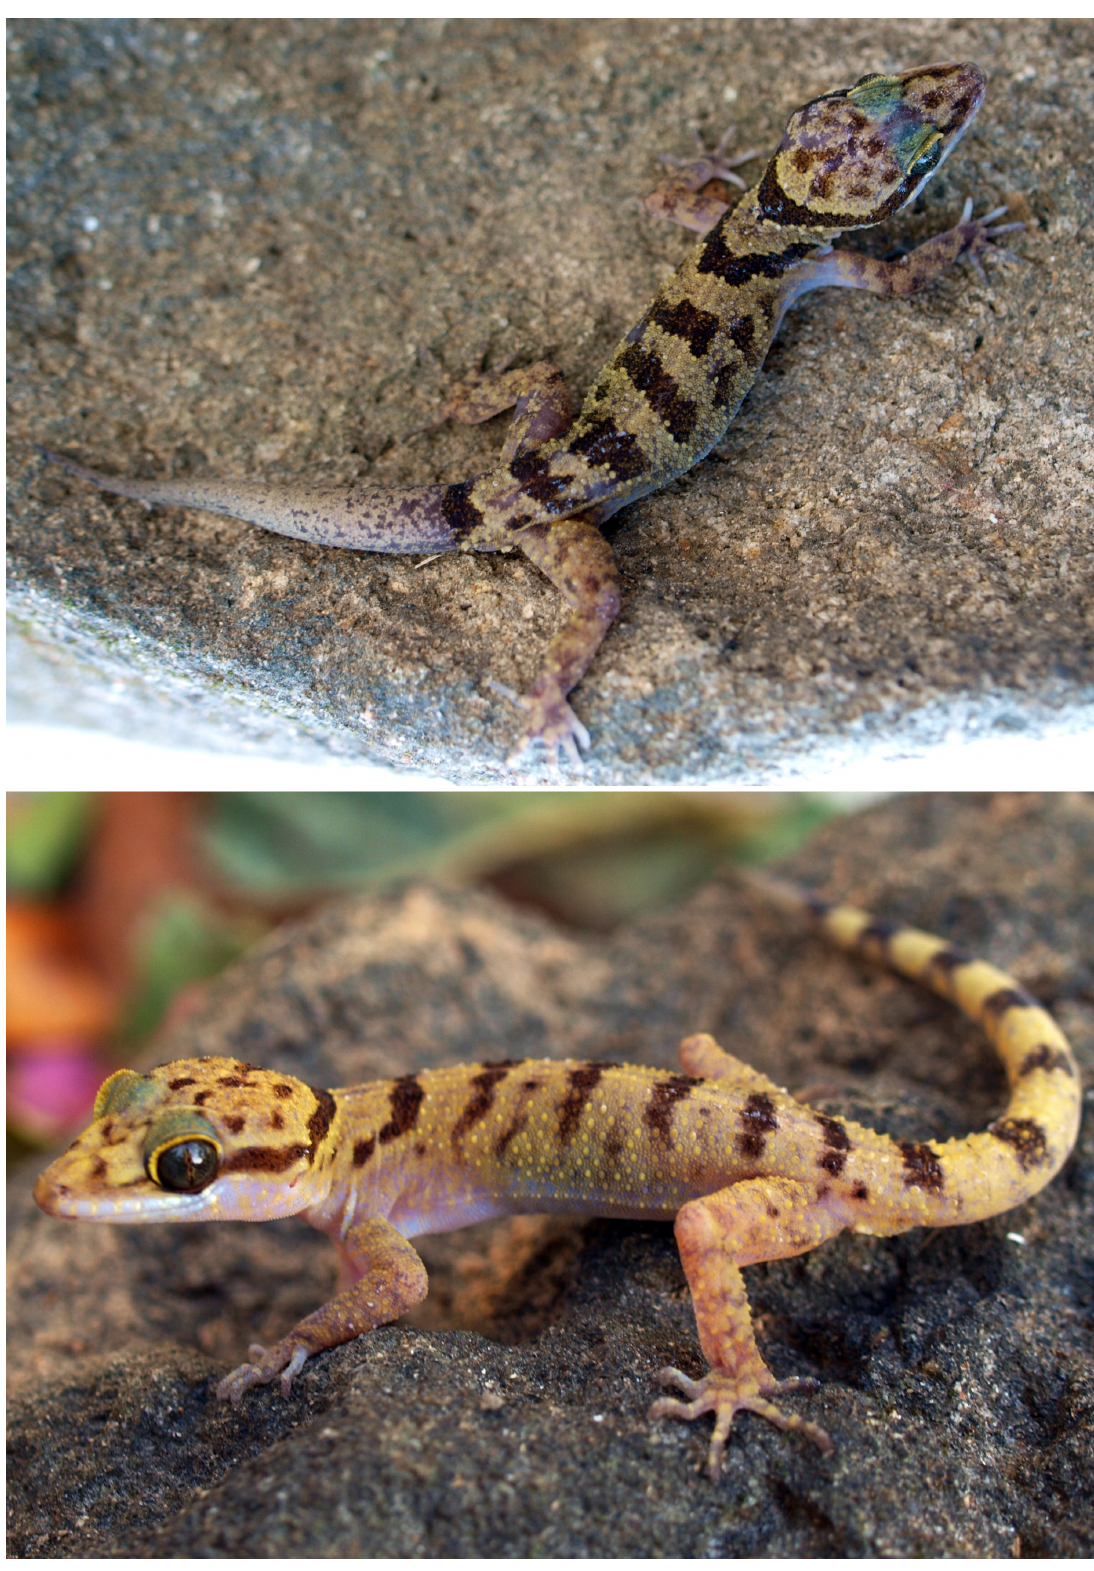
Fig. 3. Cyrtodactylus chungi sp. nov. in life. Top: holotype, ♂ (IEBR 4581). Bottom: paratype, ♀ (IEBR 4582). Photos T.M.